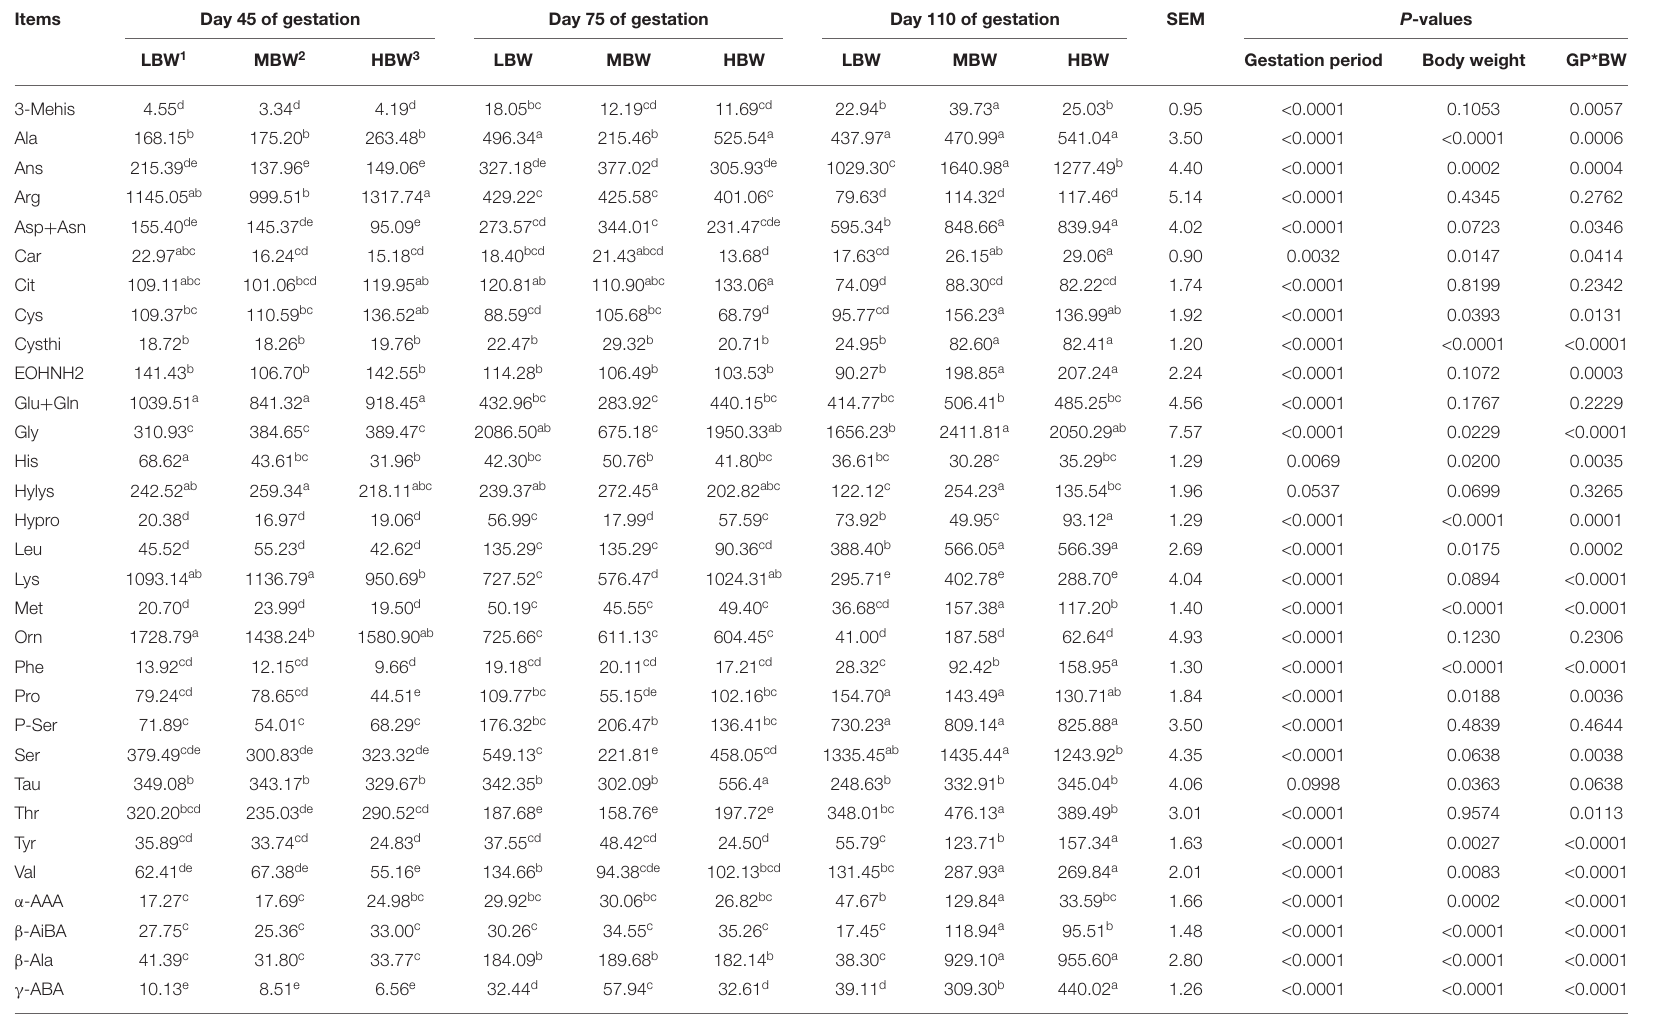
TABLE 7 | Free AA profiles in allantoic fluid of fetal pigs with LBW, MBW, and HBW at different gestation periods (nmol/ml).